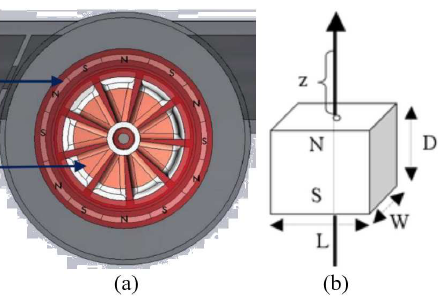
Figure 5. ( a ) magnet layout of water turbine generator; ( b ) block magnet model.